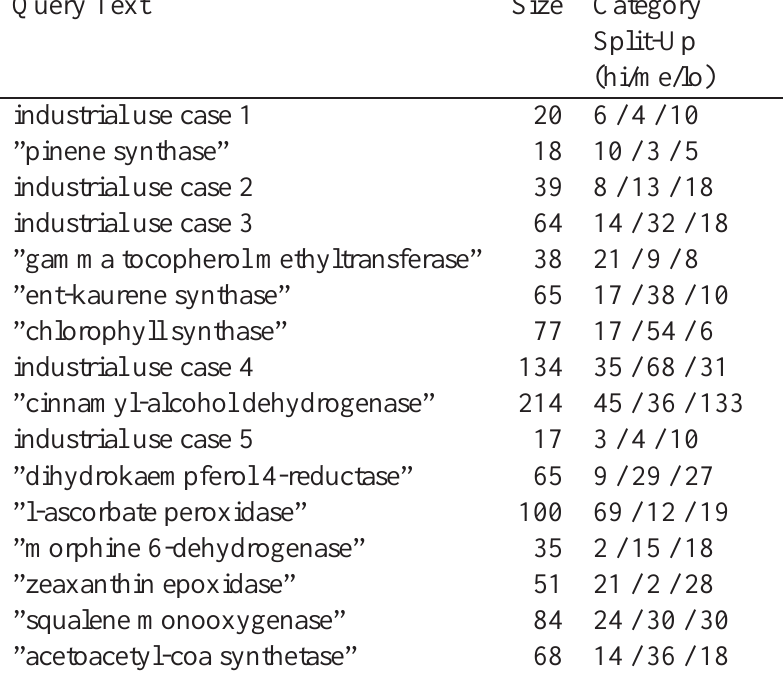
Table 2: Overview of the training data